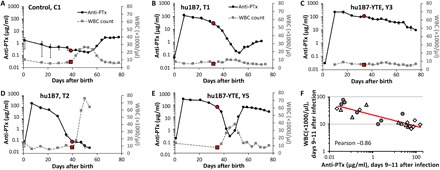
Anti-PTx antibody concentrations correlate inversely with leukocytosis.(A) Control animals exhibited rapid onset of leukocytosis after infection. For control animals such as C1 that were ultimately able to control infection and did not require euthanasia, leukocytosis diminished rapidly upon appearance of an endogenous anti-PTx response. (B) Most antibody-treated animals exhibited typical antibody clearance kinetics with an early α-decay, followed by a slower β-decay phase, as seen in animal T1. Endogenous anti-PTx antibodies appeared ~12 days after infection but were not always distinguishable from the remaining hu1B7 background. (C) This is apparent in animal Y3, which cleared hu1B7-YTE more slowly than hu1B7. Other baboons had evidence of α, β, and additionally γ-decay kinetics, which correlate closely with the WBC rise and appearance of antidrug antibodies (fig. S4). This was especially pronounced and early in animals (D) T2 and (E) Y5, which shared the same mother. (F) Anti-PTx titers correlate most strongly with WBC counts when both are measured on days 9 to 11 after infection, just after disease is most severe, with control animals shown in circles, hu1B7-treated animals in triangles, and hu1B7-YTE–treated animals in diamonds. The day of infection is indicated by a red marker in both the anti-PTx and WBC data plots. Comparisons for all animals are shown in fig. S3.